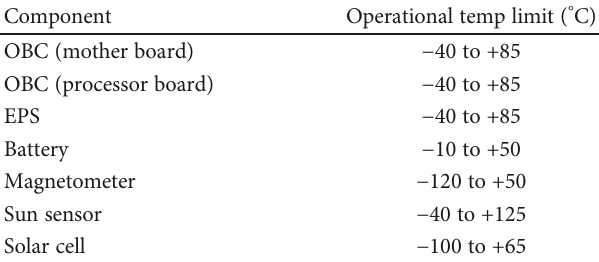
Table 5: Operational temperature limits.